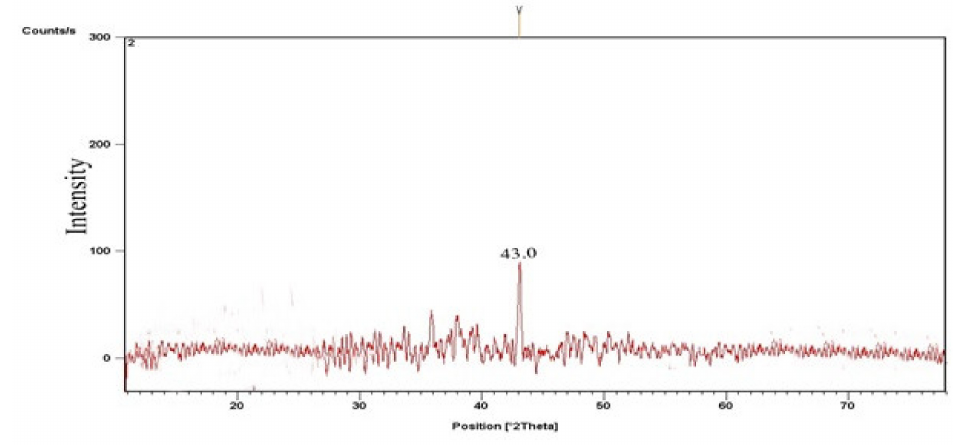
Figure 3. XRD results of CPC